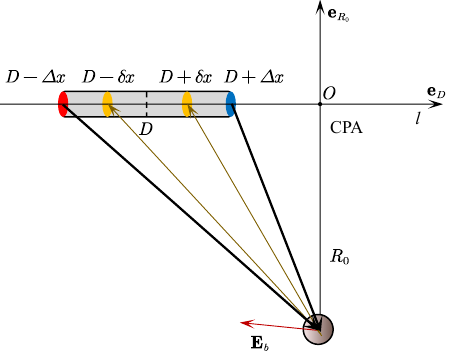
Figure 1. AEAD system